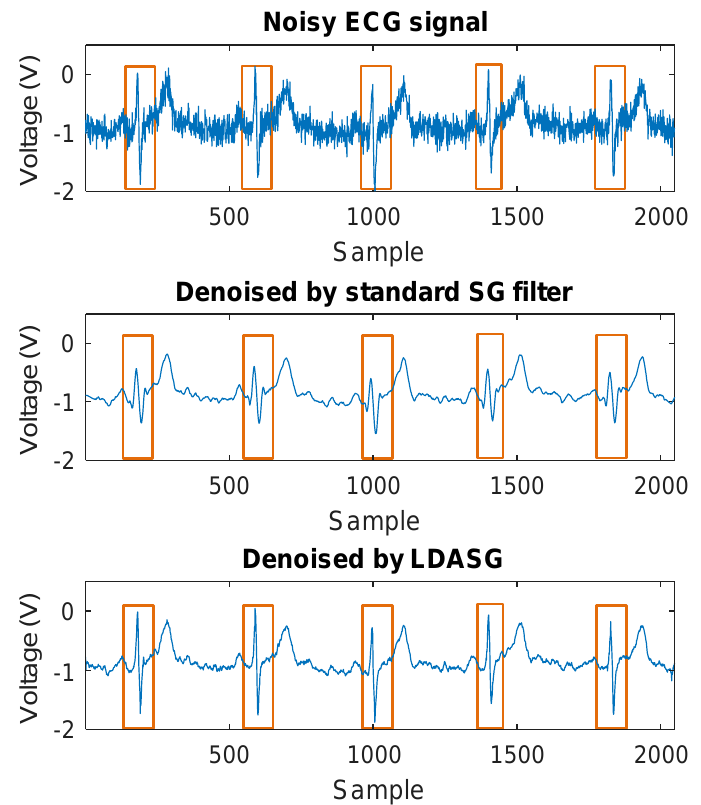
Figure 4. Denoising results of standard SG filtering and the proposed method. With comparable noise elimination performance, the standard SG filter has greater distortions at high variation parts, especially at R peaks, than the proposed